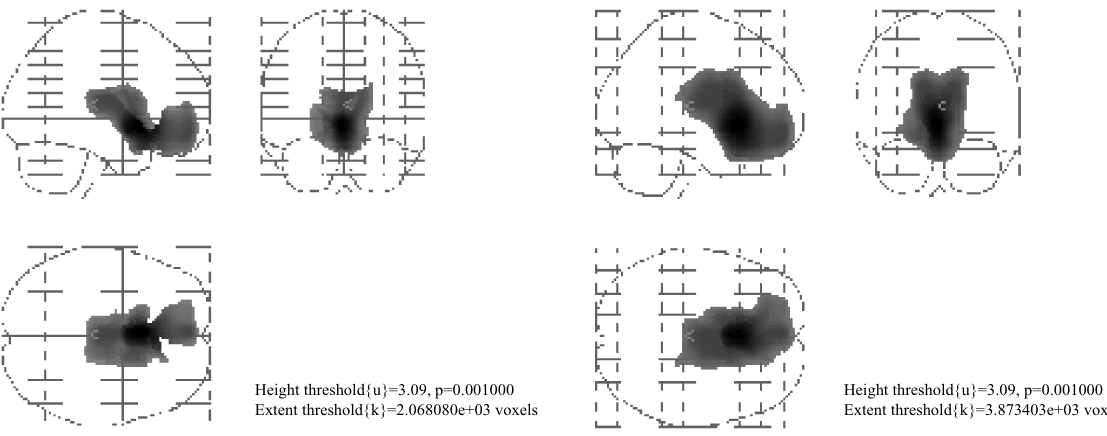
Fig. 2. SPM results comparing ACoA patients with control subjects; Fig. 2(a)(left): whole brain normalisation, Fig. 2(b)(right): cerebellar normalisation. The figures illustrate the orthogonal maximum intensity projections of the thresholded statistical parametric map. The map is thresholded at an individual voxel value of 3 . 09 ( p = 0 . 001 ) and clusters of voxels having a probability of chance occurrence of < 0 . 001 , when corrected for multiple comparisons, are